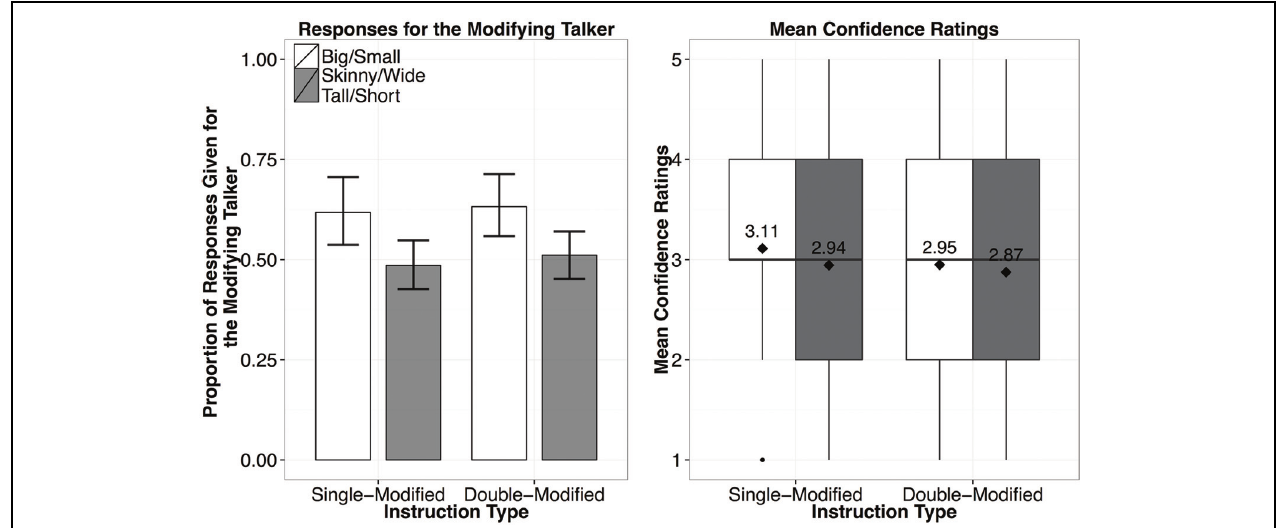
FIGURE 9 | Results from Experiment 4, showing the proportion of responses given for the modifying speaker by Instruction Type (left), and the confidence ratings for responses by Instruction Type (right; diamond dots reflect the mean rating out of